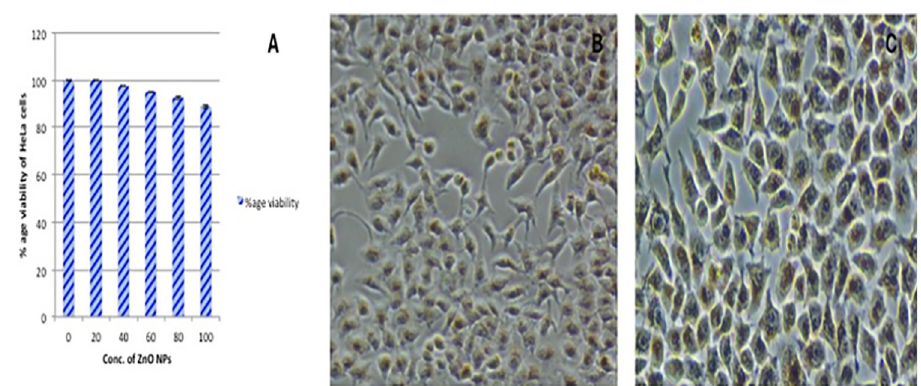
Fig 9. Cytotoxicity assay for ZnO NPs using HeLa cell lines (A) Percentage viability of HeLa cells treated with different concentrations of ZnO NPs (0–100 μ g/ml). 100% of cell viability indicates zero toxicity. (B) Phase-contrast microscopy of untreated cells (control) (C) Cells treated with ZnO NPs at a concentration of 60 μ g/ml.